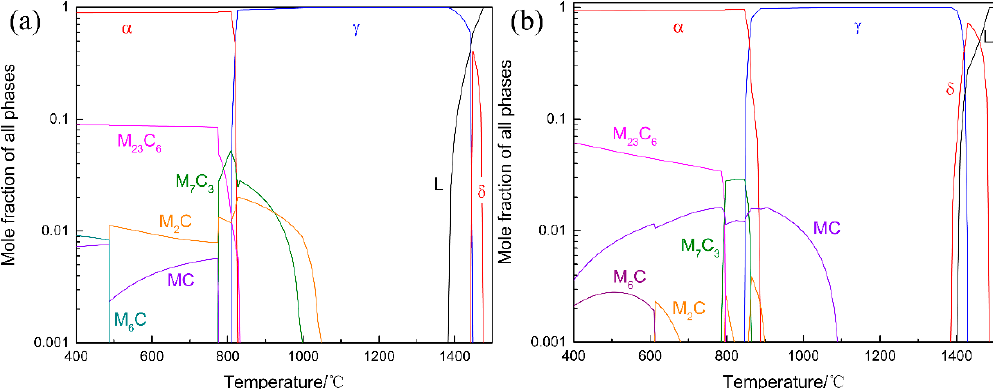
Figure 3. Results of the thermodynamic calculation of the equilibrium precipitation phases of the ( a ) 5Cr5Mo2 steel; and ( b ) H13 steel.